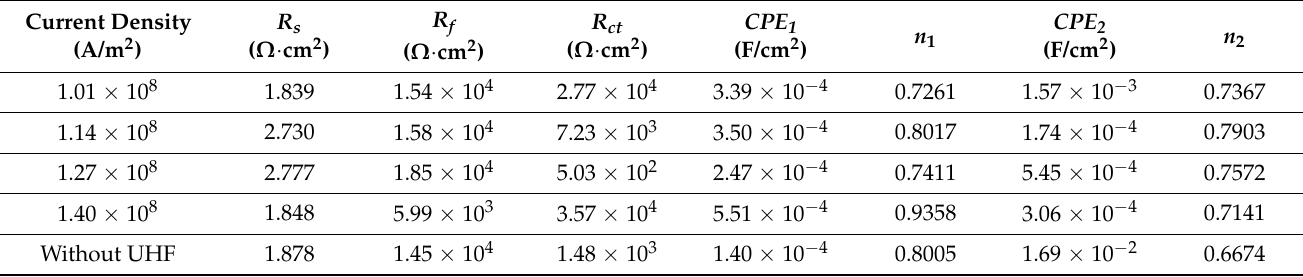
Figure 18. Equivalent circuit of EIS spectra. Table 4. EIS fitting results of the tested samples under different current